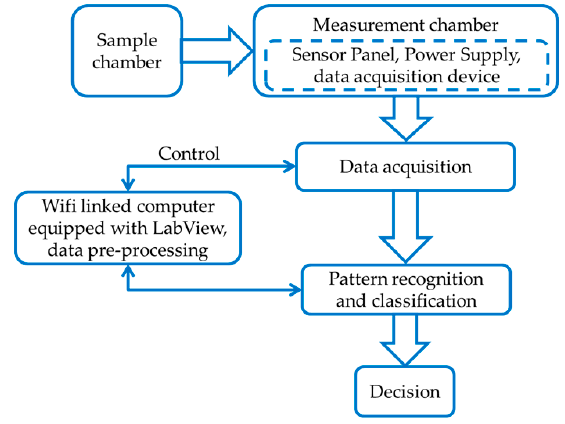
Figure 1. Design process of an electronic nose.